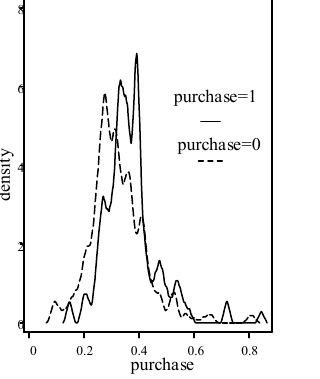
Figure 4. Overlapping test of participating organizations' purchase.